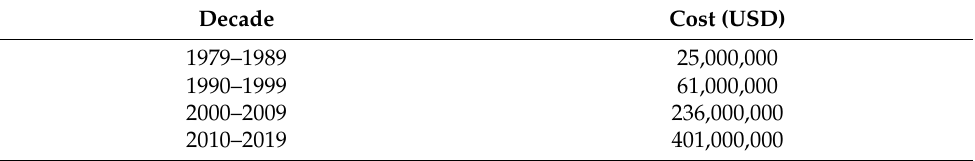
Table 2. Average annual fire suppression expenditure for the emergency fund of California De- partment of Forestry and Fire Protection (adapted from